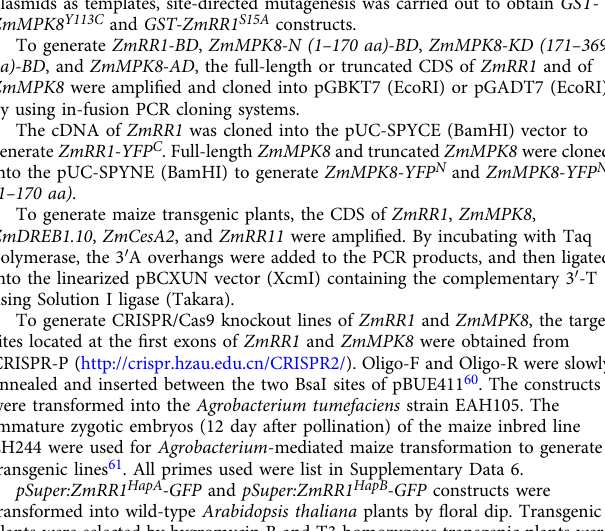
Fig. 7 Proposed model of ZmRR1-mediated chilling tolerance. Under cold stress, ZmRR1 protein accumulates to enhance chilling